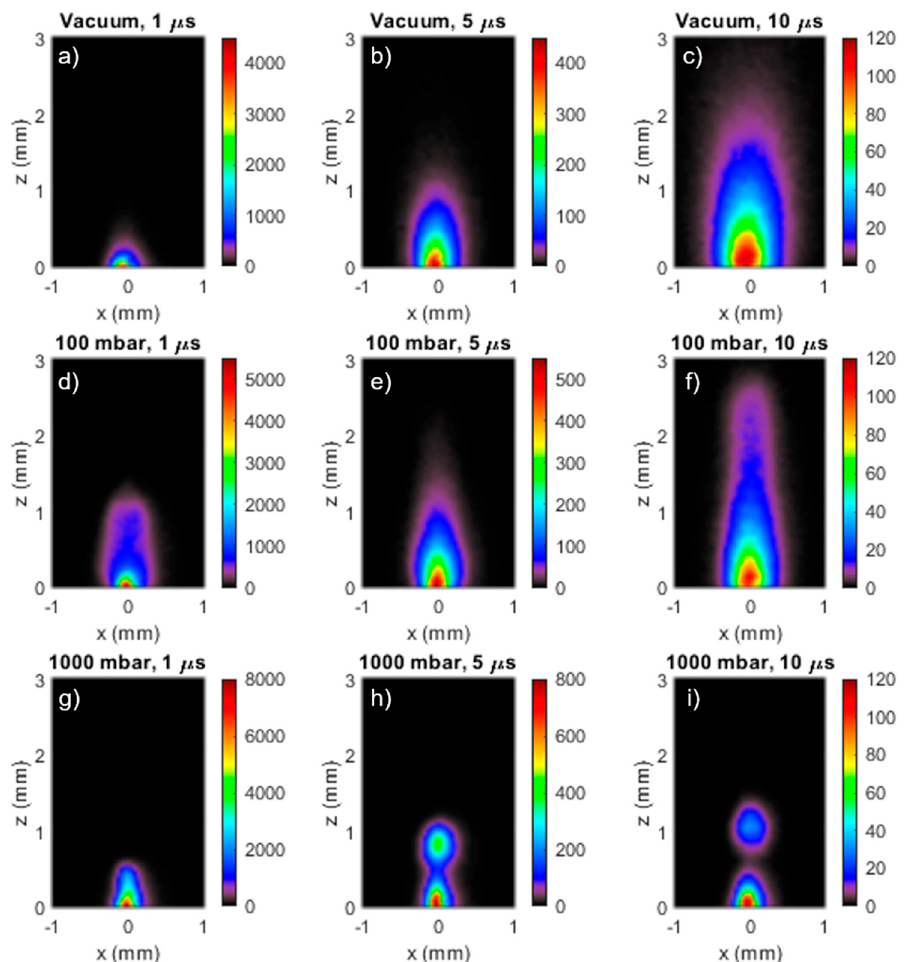
Figure 2. Images of the ablation plume optical emission in vacuum ( a – c ) at 1 μ s, 5 μ s and 10 μ s after the laser pulse, respectively, in 100 mbar Ar ( d – f ) at 1 μ s, 5 μ and 10 μ s, respectively, and in 1 bar of ( g – i ) at 1 µ s, 5 µ s and 10 µ s, respectively. The scale bar units are counts per Ar ( g – i ) at 1 μ s, 5 μ s and 10 μ s, respectively. The scale bar units are counts per ns.